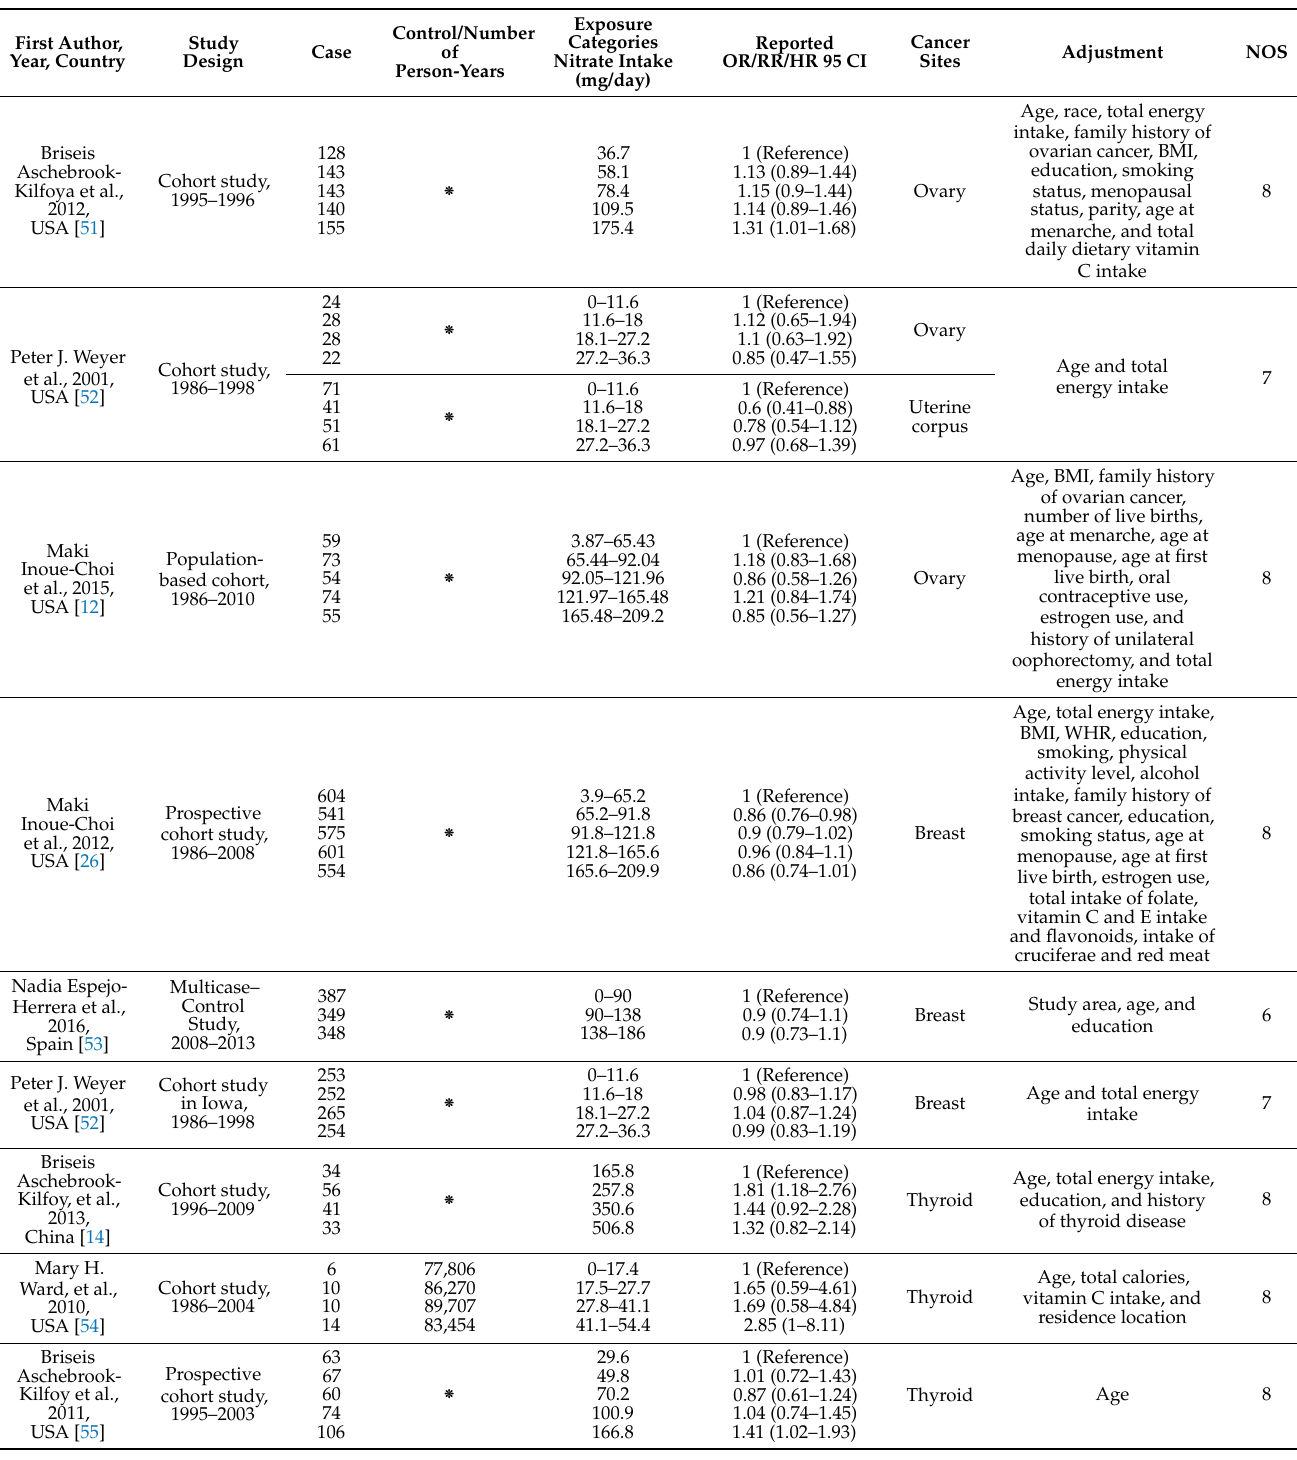
Table 2. Characteristics of the included studies and reported associations between dietary nitrate (mg/day) and cancer